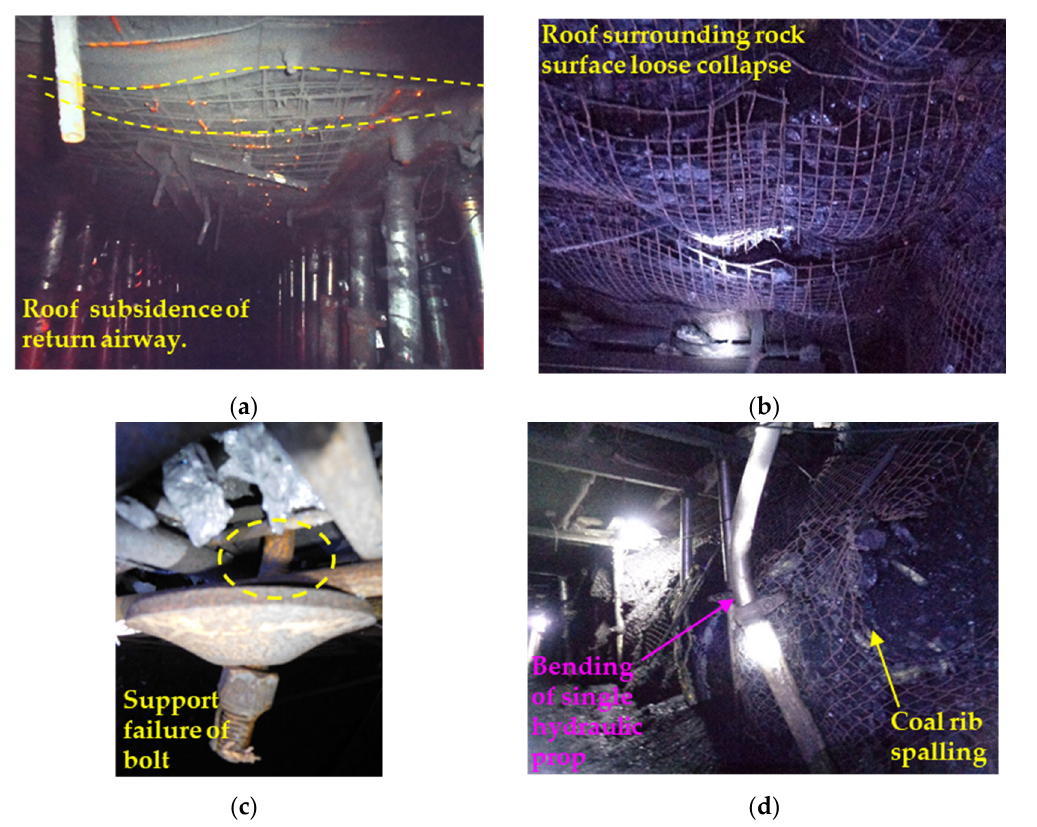
Figure 3. The 1304 working face return air roadway with single hydraulic prop advance support in real life.